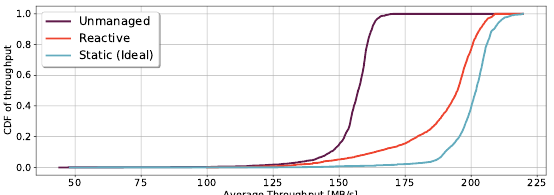
Figure 5. Distribution of average throughput per